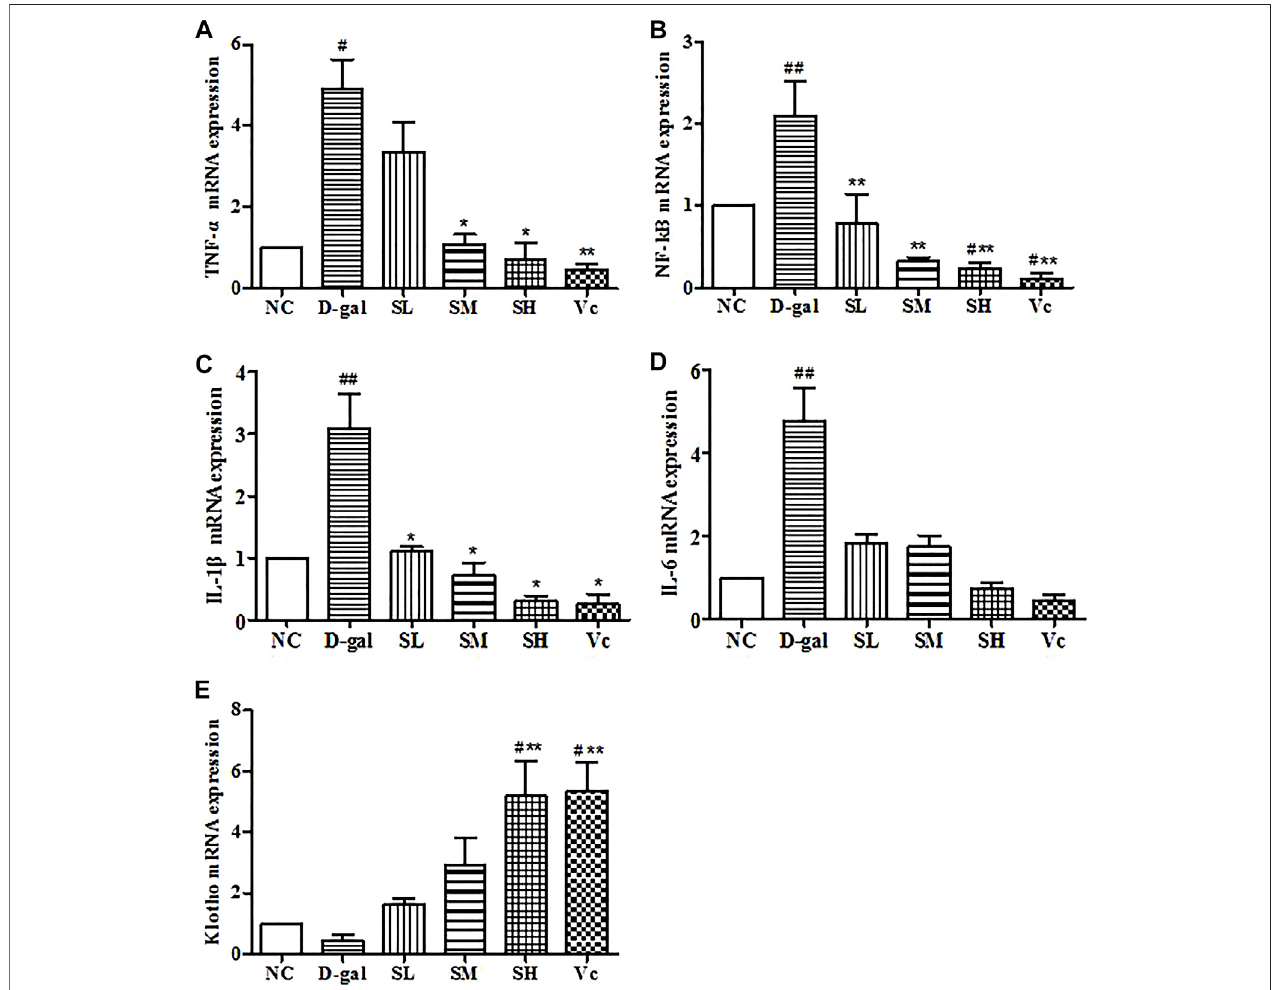
FIGURE 9 | mRNA levels of TNF – α , NF – kB, IL – 1 β , IL – 6 and Klotho in mice liver. Compared with normal group, #: p < 0.05, ##: p < 0.01; Compared with D – gal group, *: p < 0.05, **: p < 0.01. NC: normal control group; D – gal: D – gal model group; SL: low – dose SDE group; SM: medium – dose SDE group; SL: high – dose SDE group; Vc: Vc positive control